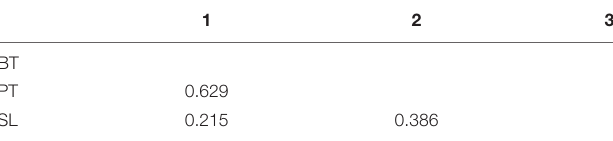
TABLE 4 | Heterotrait-Monotrait Ratio (HTMT).